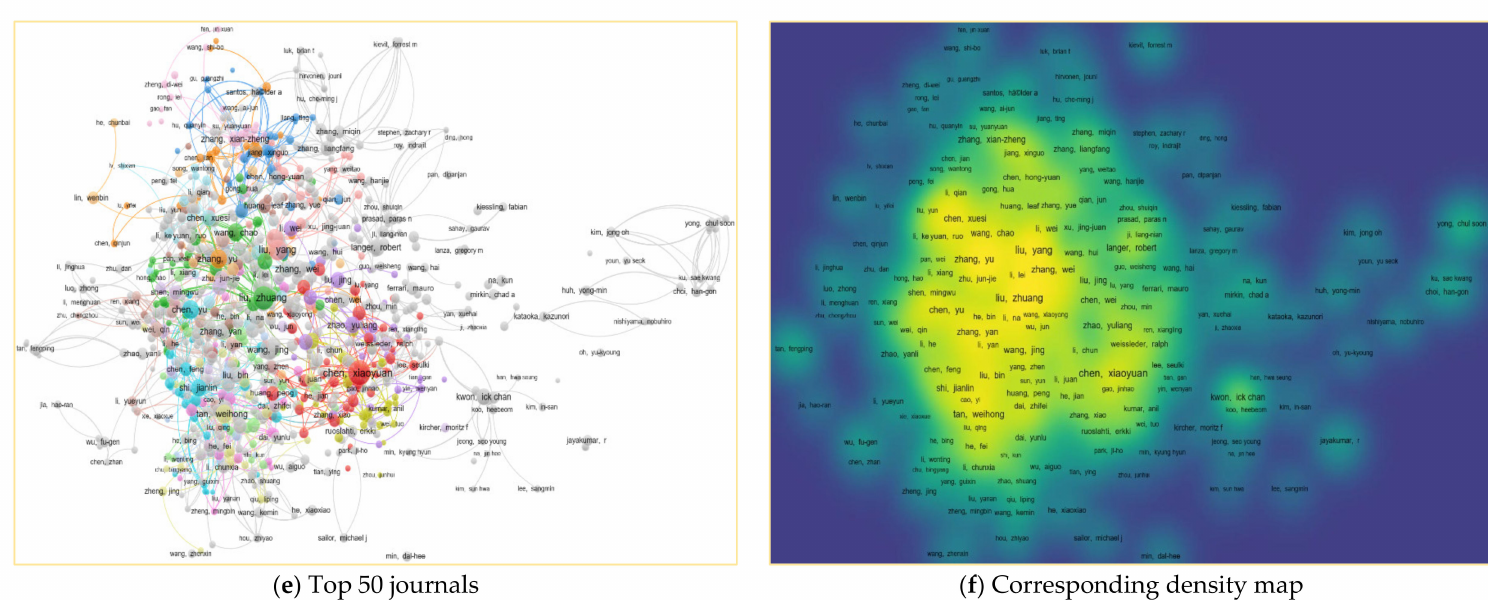
Figure 7. Co-authorship network and density map for cancer nanotechnology, 2000–2021, for the three scenarios in ( a , c , e ) representing co-author network for each dataset, and their corresponding density maps shown in ( b , d , f